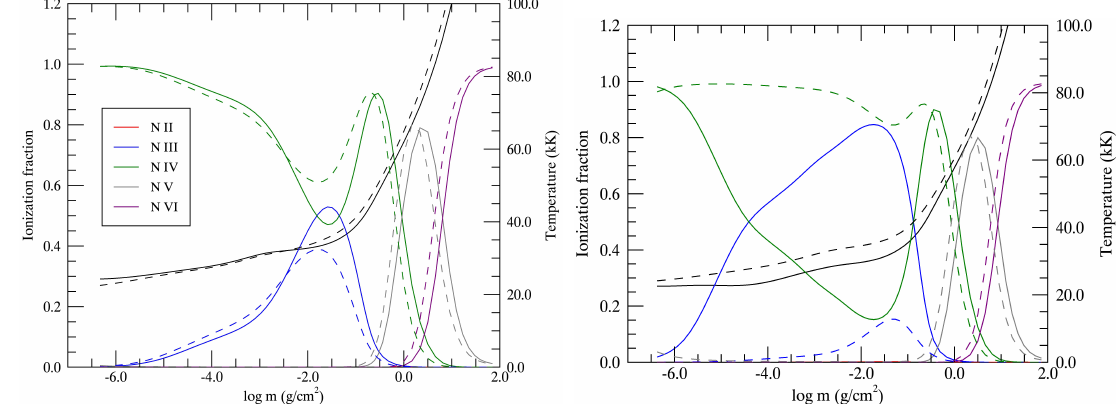
Figure 5. Left: Nitrogen ionization fractions in H/He/N models (solid) and models including C/O/Si/S/Fe/Ni also (dashed lines) and the temperature stratification (black). Right: Nitrogen ionization fractions in models with T eff = 40000K (solid) and 45000K (dashed) and the temperature stratification